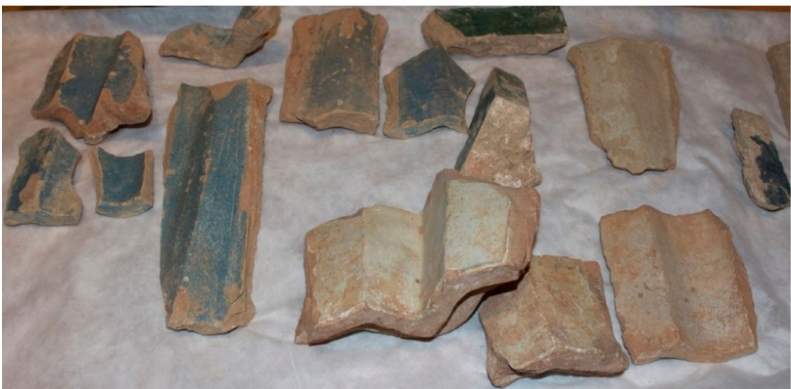
Figure 10. Remains of various skylights from the Nasrid baths in the Alhambra, now in the Alhambra Museum. © Mar í a Elena D í ez Jorge,